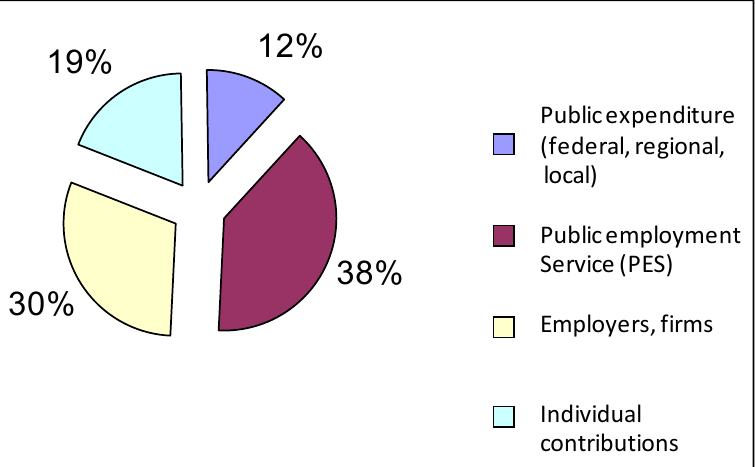
Figure 2. Estimated distribution of expenditure for adult ET in Austria